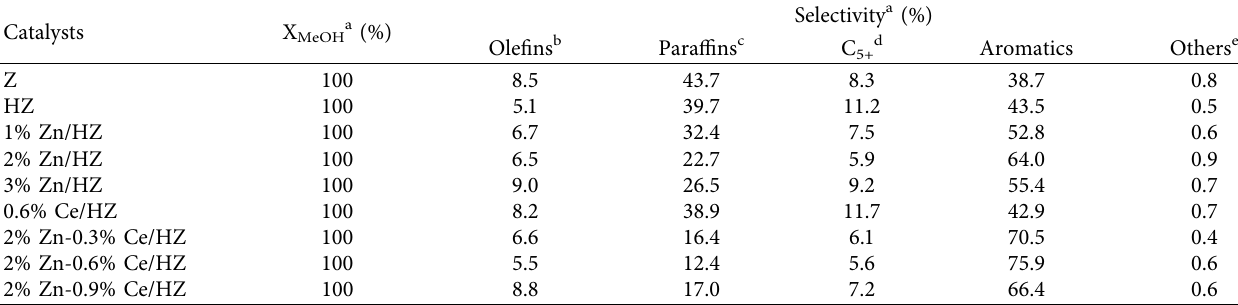
Table 1: Production distribution of MTA reaction over different catalysts.